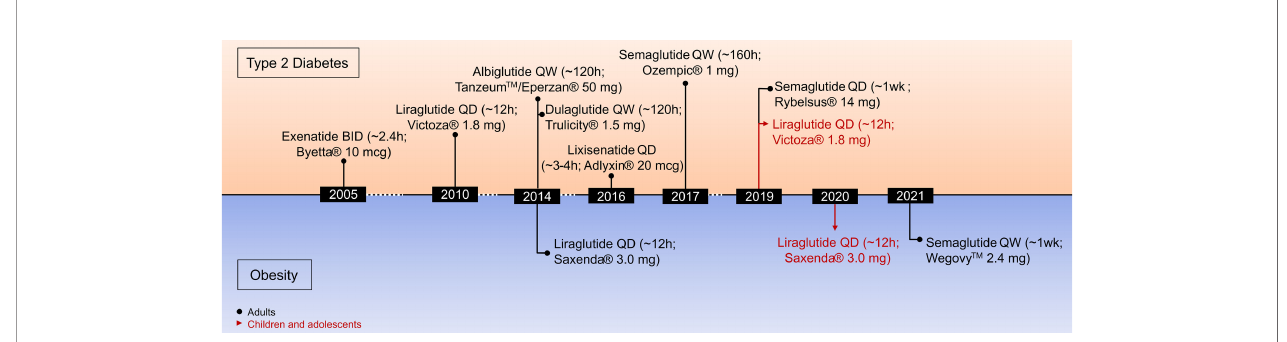
FIGURE 3 | Timeline of drug approvals by the U.S. Food and Drug